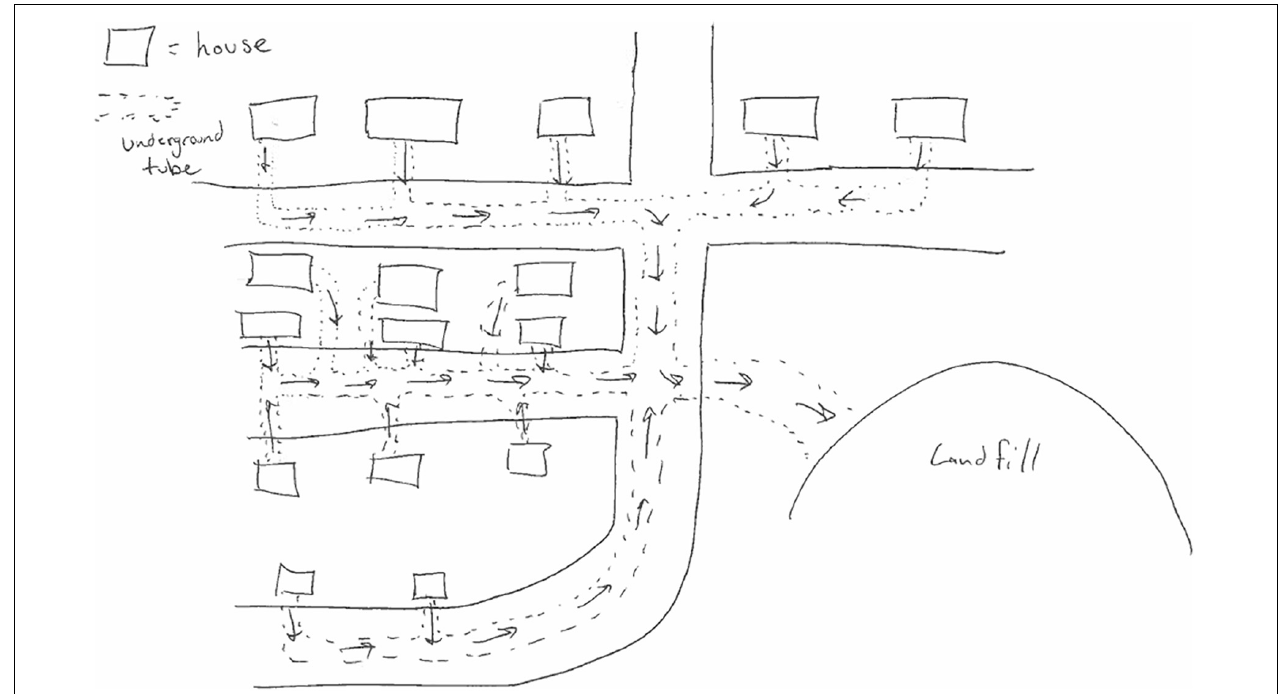
FIGURE 5 | An underground, community-implemented litter collection system that received an originality score of